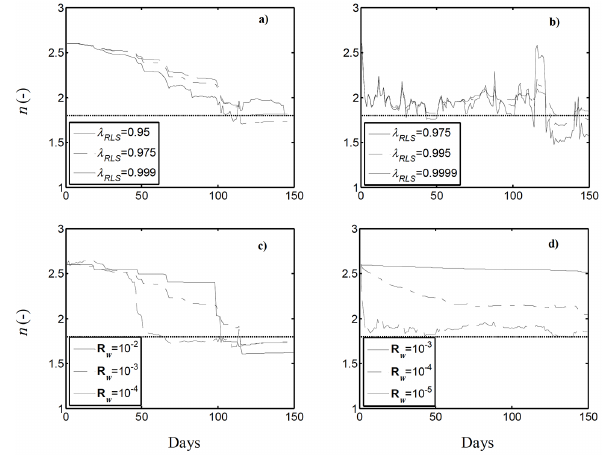
Figure 10. Daily retrieval of parameter n with the DSUKF algo- rithm, considering different values of the coefficients λ RLS (see Eq. 25) and of the artificial observation noise covariances, accord- ing to the scenarios of Table 3: (a) scenarios 2–4; (b) scenarios 6–8; (c) 1, 3 and 5; (d) scenarios 8–10. Simulations involve the initial parameters set S4( 1) and an observation depth OD =